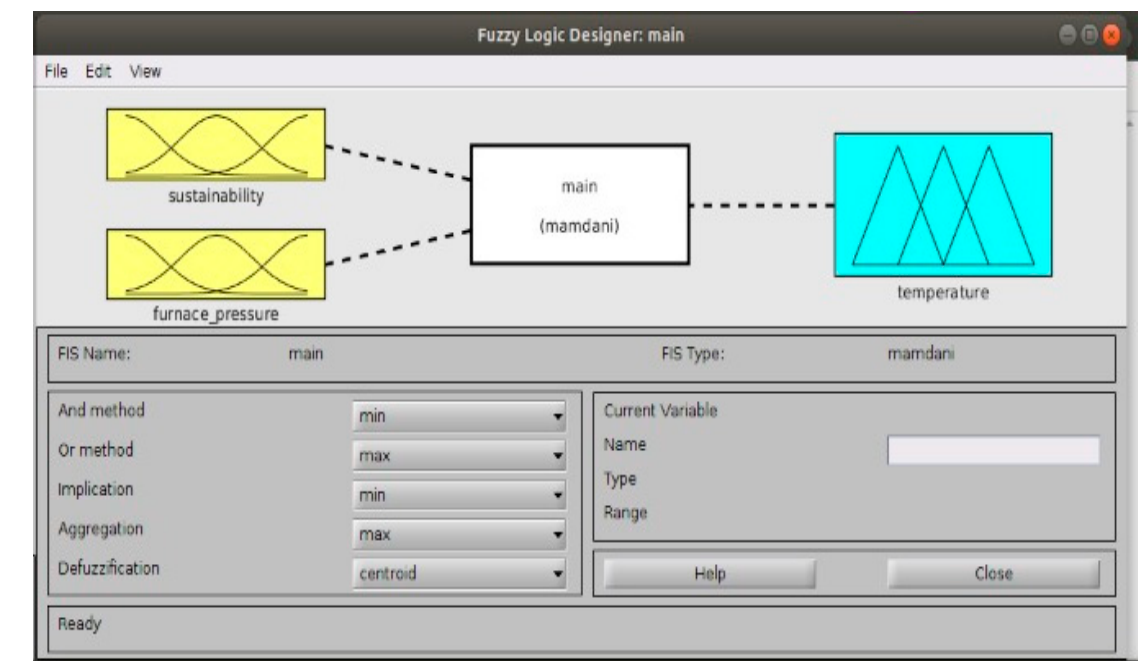
Figure 3. FIS-Editor window for the problem being solved.